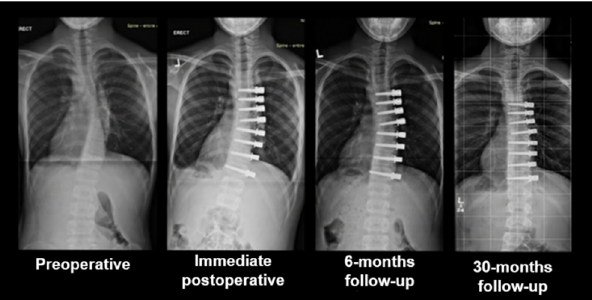
Figure 9. Evolution of the spine curve from the preoperative aspect to long-term follow-up.